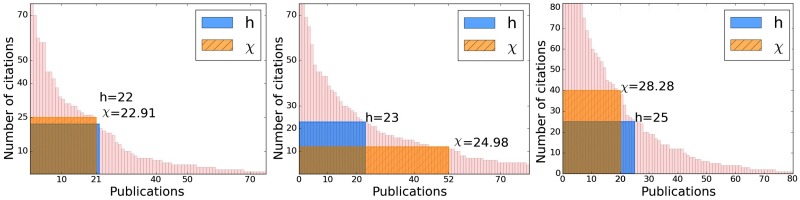
Examples of authors for the Google Scholar data set: k ≈ h (left) k > h (middle) k < h (right).